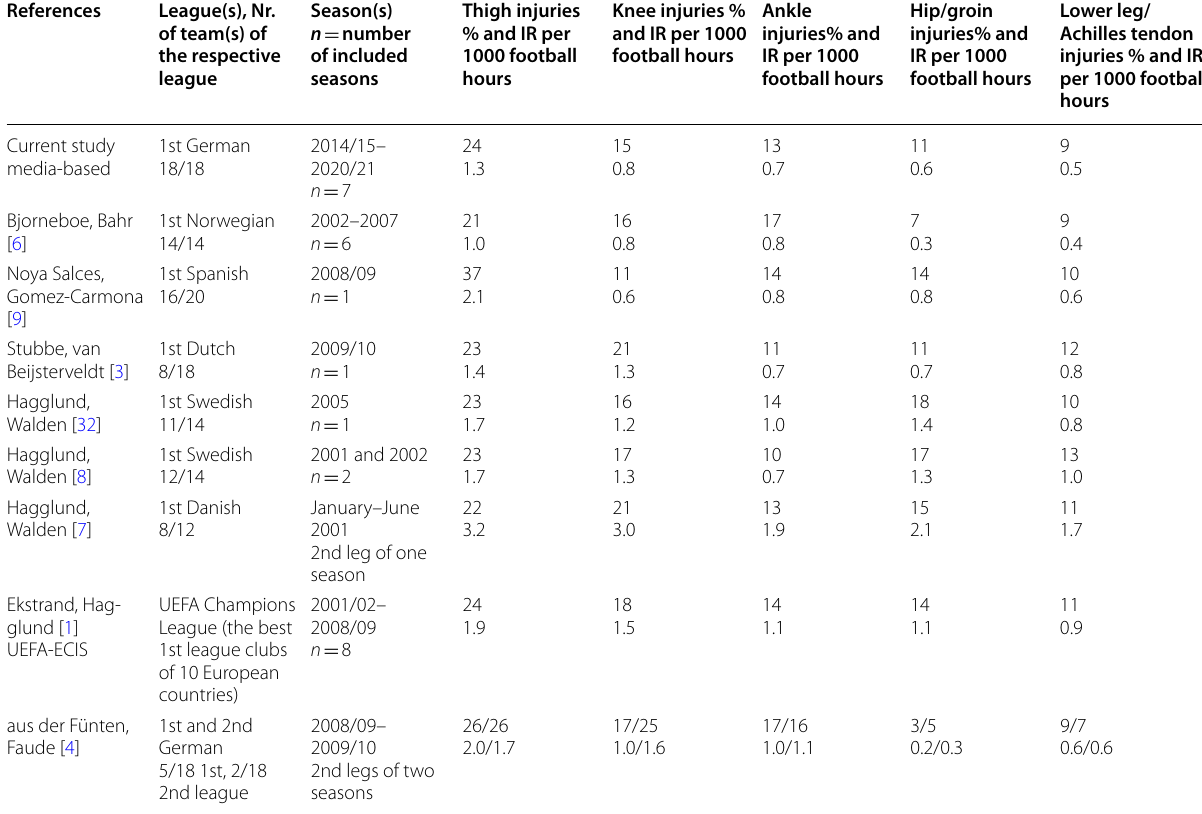
Table 7 (Inter)national comparison of injury